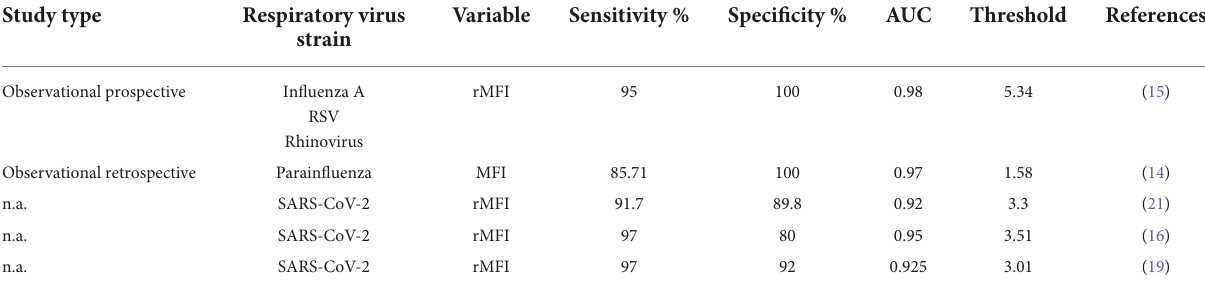
TABLE 1 Clinical trials indicating the diagnostic performance of monocytic